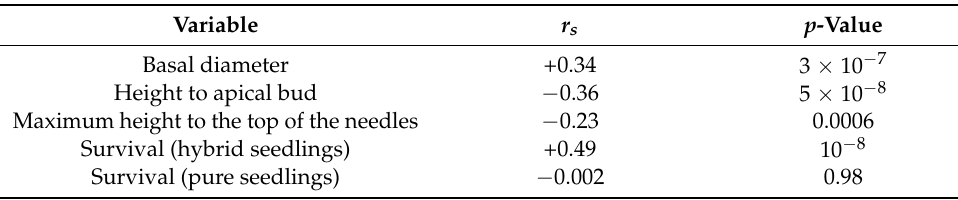
Table 7. Spearman’s correlation ( r s ) (and p -value) between the stomatal density and the basal diameter, height to the apical bud, and maximum height to the top of the needles per seedling. In addition, Spearman’s correlations ( r s ) (and p -value) between the stomatal density and survival in seedlings of the three selected pure pine species ( Pinus durangensis , P . engelmannii, and P. teocote ) and their hybrids ( P. durangensis × P. arizonica , P. durangensis × P. engelmannii , P. engelmannii × P. arizonica , and P. teocote × P . leiophylla ) ( α = 0.025) are shown for each